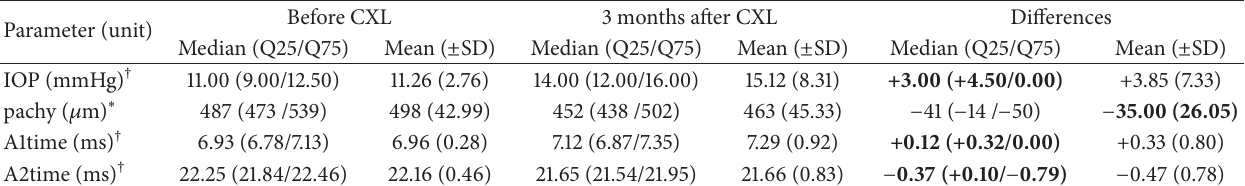
Table 3: Differences for the parameters with statistically significant changes after CXL.